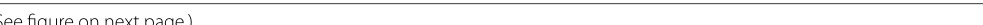
figure on next Fig. 4 LINC00240 inhibits oxidative stress‑induced pyroptosis of trophoblasts in preeclampsia model in vitro by negatively targeting miR‑155. A LINC00240 levels were measured using qPCR in HTR‑8/SVneo cells after indicated treatments. B MiR‑155 levels were measured using qPCR in HTR‑8/SVneo cells after indicated treatments. C Nrf2 mRNA levels were measured using qPCR in HTR‑8/SVneo cells after indicated treatments. D Nrf2 protein levels were measured by western blotting in HTR‑8/SVneo cells after indicated treatments. E ROS and MDA levels were measured using ROS assay Kit and MDA assay Kit, respectively. F Protein levels of HO‑1, NQO1 and eNOS were measured by western blotting. G Caspase‑1, a pyroptosis marker, was measured using flow cytometry. H Protein levels of pyroptosis markers (caspase‑1, NLRP3, ASC and HMGB1) were measured by western blotting. I HMGB1 protein levels were measured using ELISA. All the experiments were repeated at least three times. * P < 0.05, ** P < 0.01 and *** P <